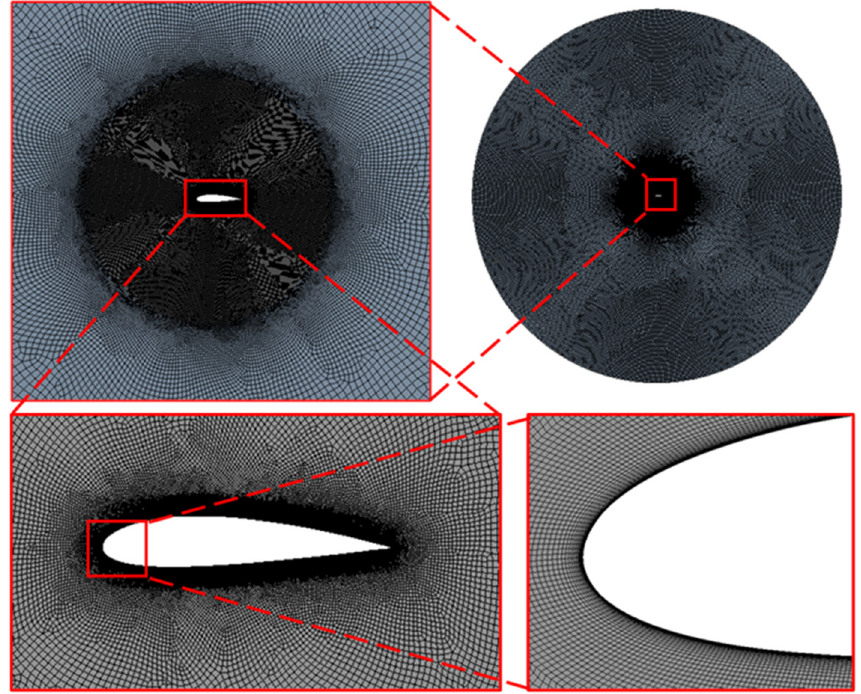
Figure 3. Computational mesh of 0.124 M elements with successive magnifications in the internal zone and around the airfoil. zone and around the airfoil. Table 1. Mesh independence study results.